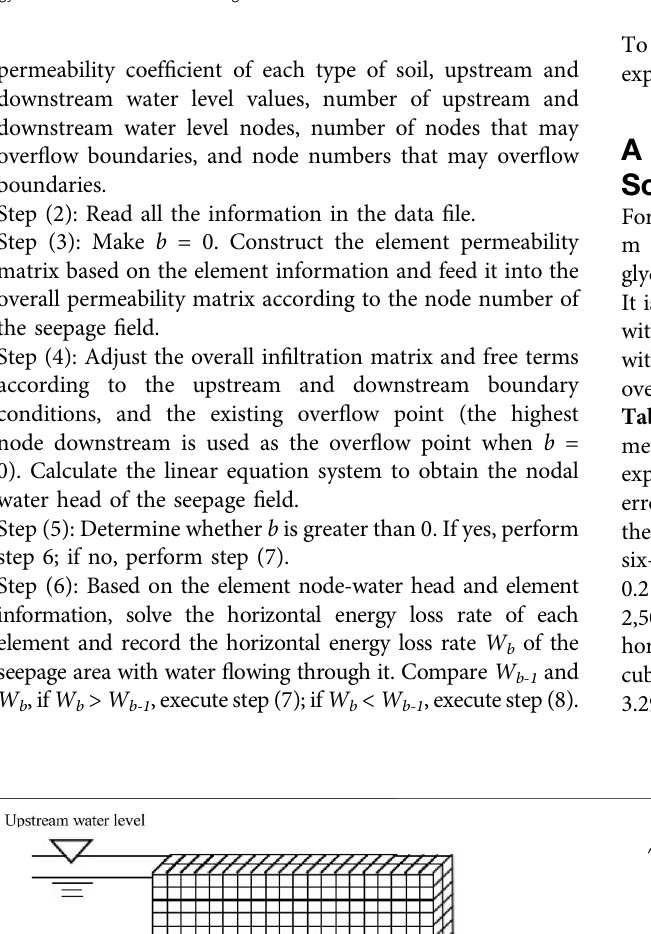
Frontiers in Earth Science |